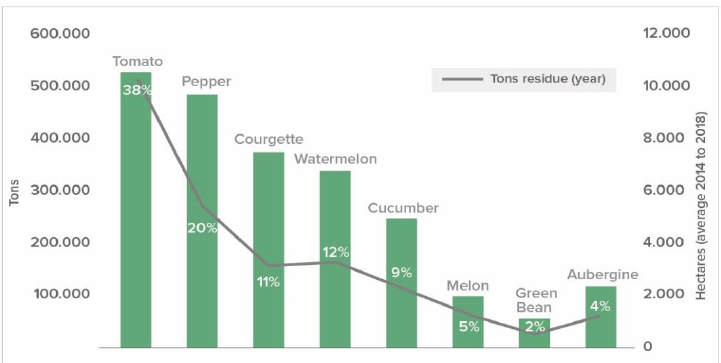
Figure 6. Average land area per crop and average annual production of waste biomass per